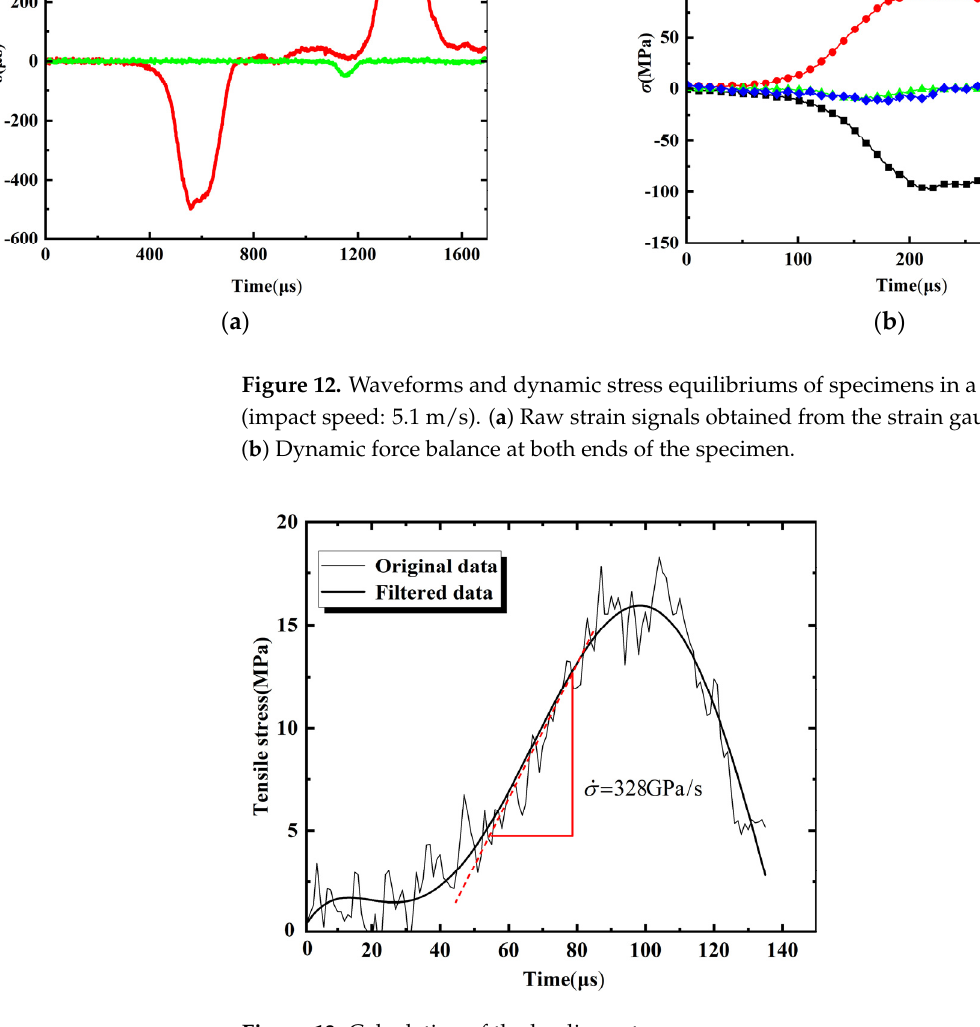
Figure 13. Calculation of the loading rate.